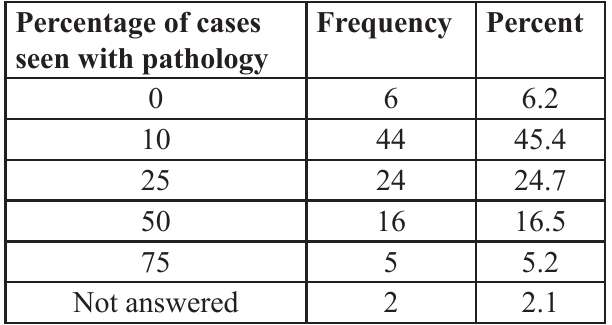
Table 2: Percentage of cases seen with pathology